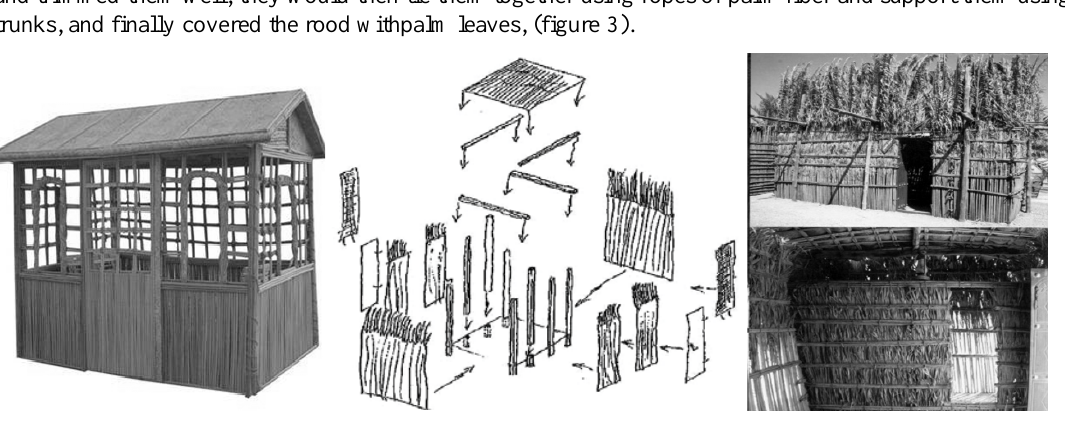
Figure 3. Caption of old Arish from a palm fronds and leaves.